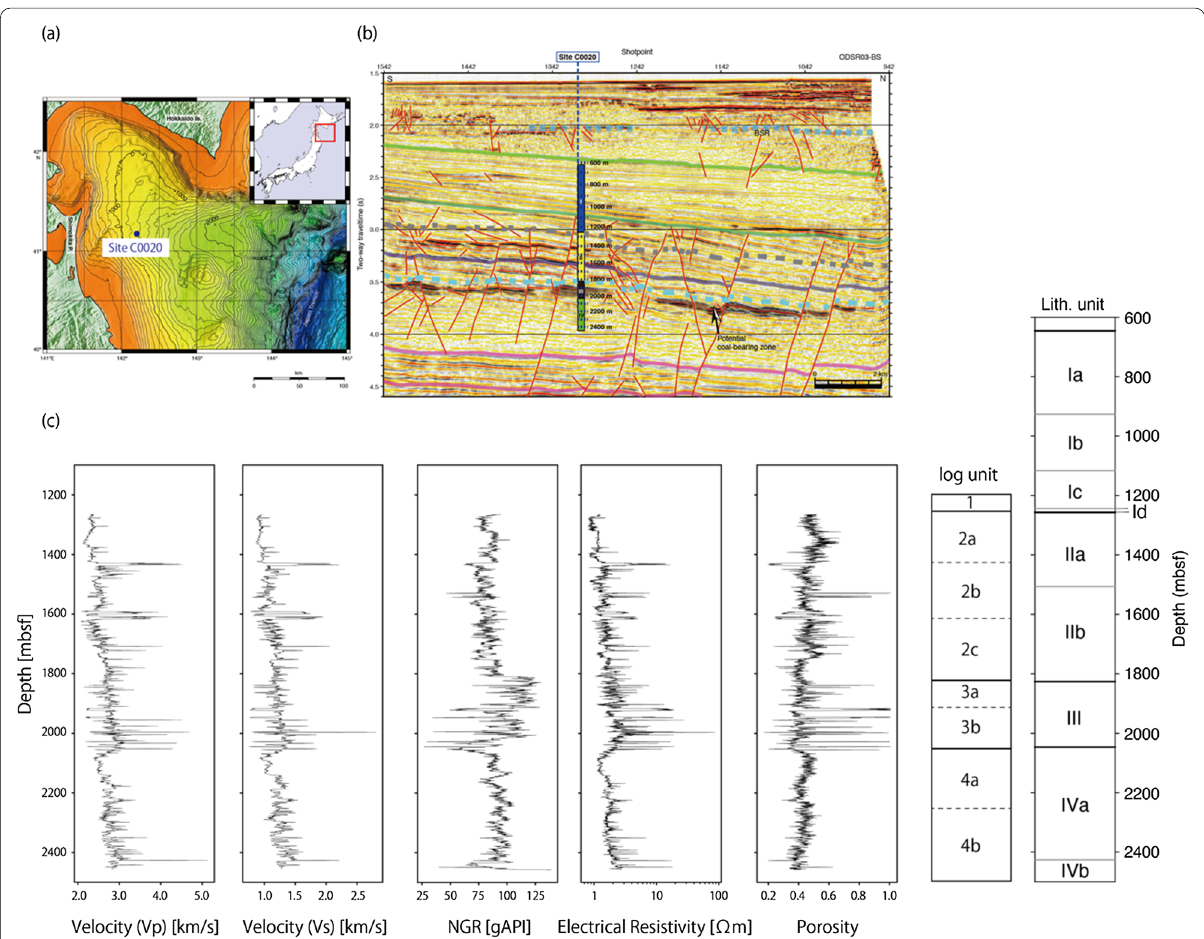
Fig. 8 Geological settings and data summary at Site C0020. a Regional map at the Japan Trench showing the location of Site C0020, after Expedition 337 Scientists (2013a). b Local seismic reflection image after Expedition 337 Scientists (2013a). c Logging data and previously reported log‑ and litho‑units (Expedition 337 Scientists